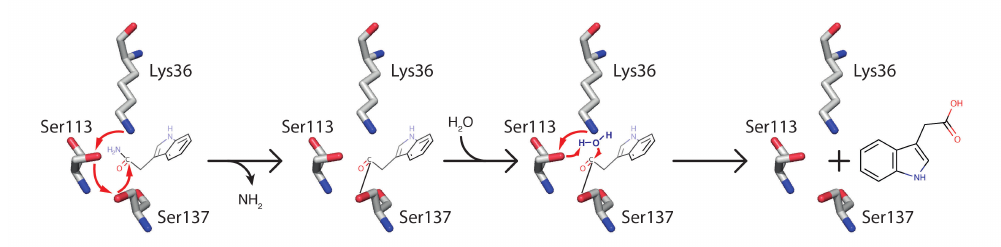
Figure 1. Proposed mechanism for the conversion of IAM by Arabidopsis AMI1. The enzymatic reaction initiates with a nucleophilic attack of the α carbon atom of IAM by Ser137. Lys36 acts as a catalytic base and, possibly, receives protons from Ser113 in a proton relay. After the liberation of ammonia, an intermediate acyl-enzyme complex is formed, which disintegrates after the addition of H 2 O and the release of the reaction product,